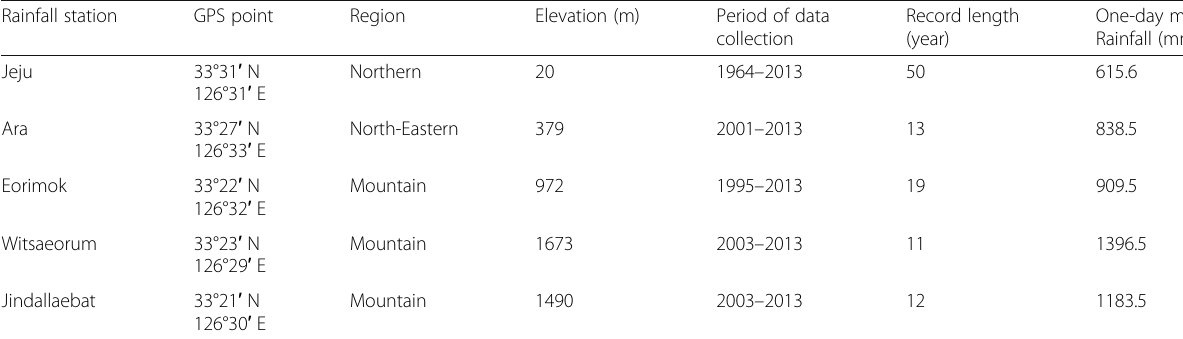
Record length (year)